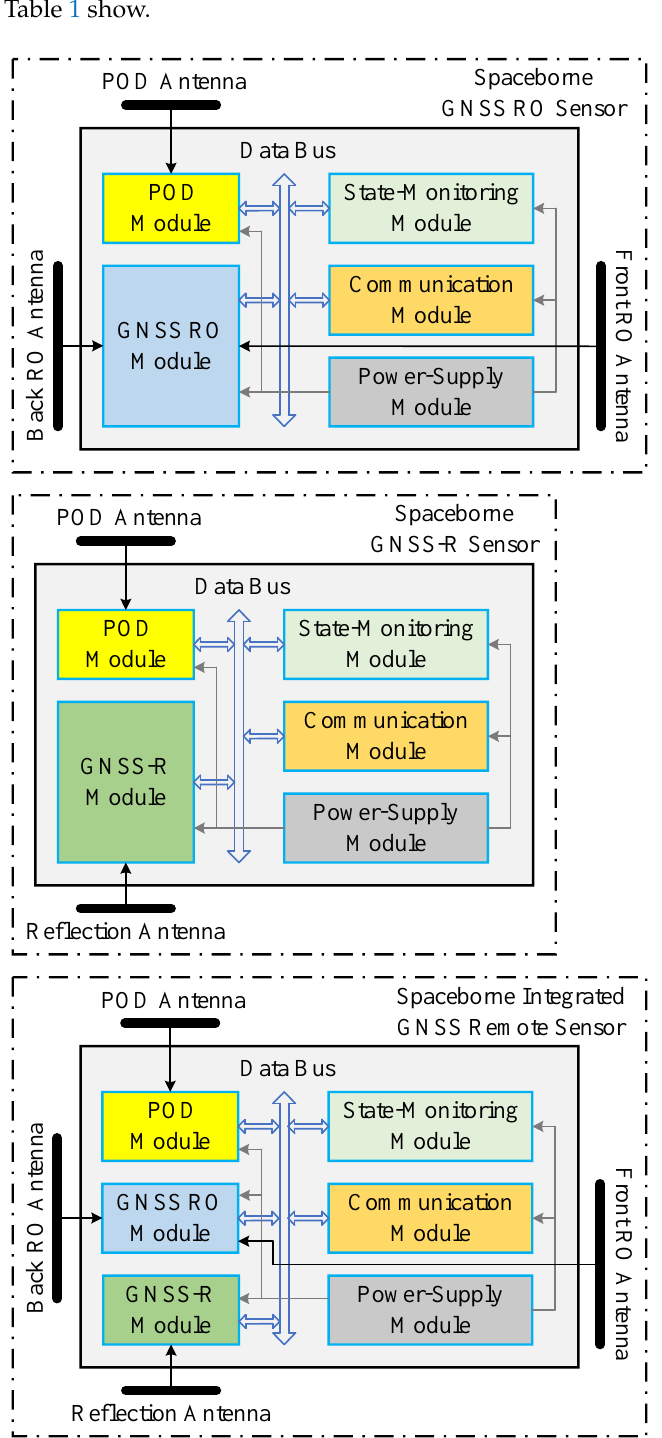
Figure 1. The block diagram on top shows the typical system architecture of the spaceborne GNSS RO sensor. The block diagram in middle shows the typical system architecture of the spaceborne GNSS-R sensor. The block diagram at the bottom shows the typical system architecture of the spaceborne integrated GNSS remote sensor.